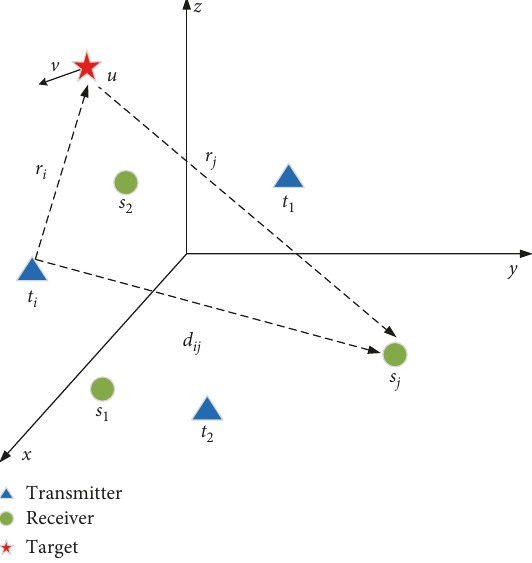
Figure 1: Geometry for multistatic